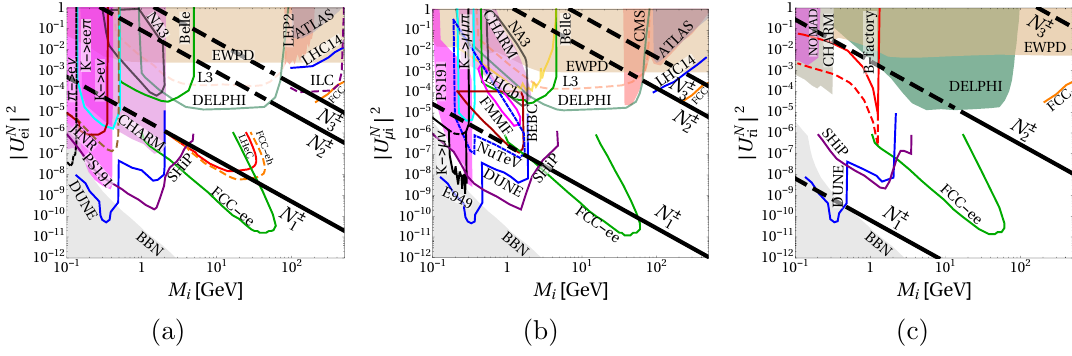
Figure 3 . Experimental bounds on and future sensitivities to the heavy lepton mixing in (cid:23) e (panel (a)), (cid:23) (cid:22) (panel (b)) and (cid:23) (cid:28) (panel (c)). The black lines show the predicted mixing of heavy leptons N (cid:6) ( i = 1 ; 2 ; 3) in a given light neutrino (cid:13)avor state as a function of M i . We take i (cid:0) (cid:1) ( Y 1 ; Y 2 ; Y 3 ) ’ 2 (cid:2) 10 (cid:0) 5 ; 0 : 007 ; 1 . Solid (dashed) parts of the black lines are expectations in the allowed (excluded)